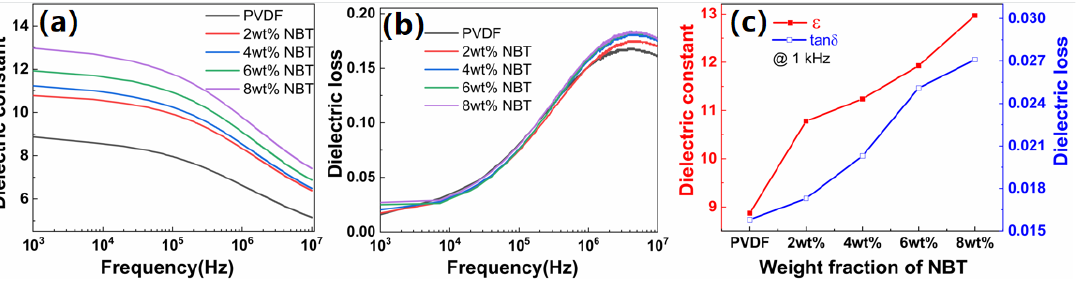
Figure 6. The frequency-dependent changes of ( a ) dielectric constant and ( b ) dielectric loss of NBT – PVDF nanocomposites; ( c ) dielectric constant and dielectric loss of NBT – PVDF nanocomposites PVDF nanocomposites; ( c ) dielectric constant and dielectric loss of NBT–PVDF nanocomposites with with various loadings of NBT nanofibers at 1 kHz. various loadings of NBT nanofibers at 1